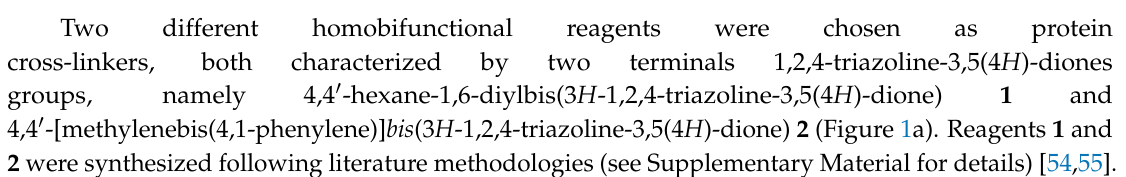
. Figure 1. ( a ) The gelatin cross-linkers hetherobifunctional triazolinediones (TADs) 1 and 2 and the corresponding reduced forms 3 and 4, respectively; ( b ) TADs stability in different solvents (DMSO, 1:1 DMSO/H 2 O, 1:1 TRIS Buffer solution-pH = 7.4/acetonitrile). The disappearance of the fuchsia color indicates the degradation of 1 and 2 . Gelatin can be easily dissolved in aqueous solutions above 37 °C; however, TADs are reported to undergo degradation in water [50], despite a certain stability of some TADs in aqueous medium reported in bioconjugation reactions by PTAD [56] or in cross-linking reaction of a synthetic Lys-Tyr polypeptide in TRIS buffer solution by difunctional TAD 2 [53]. In our hands both 1 and 2 almost immediately decomposed in any type of aqueous environment, as clearly indicated by the disappearing of their characteristic fuchsia color in a few seconds (Figure 1b). Thus, suitable reaction conditions should be found for effective gelatin cross-linking by TADs, in order to allow the cross- linking agents to react with tyrosine residues present in the protein, affording the desired chemical reaction towards network formation. Gelatin can be dissolved in DMSO, after vigorous stirring for 3 h at 37 °C at a concentration of 12 mg/mL; in addition, DMSO has proven to be fully compatible with the use of TADs [50]: DMSO solutions of 1 and 2 are stable for several hours since the characteristic fuchsia color is maintained, confirming the stability of the two cross-linking agents in this medium (Figure 1b). Thus DMSO could be the solvent of choice for the gelatin cross-linking reaction. Given